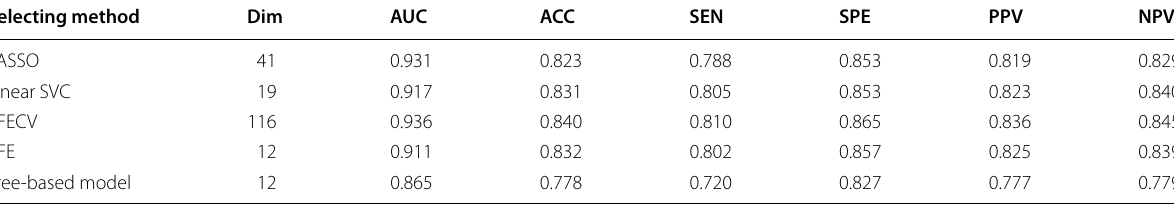
LASSO, Least Absolute Shrinkage and Selection Operator; Linear SVC, Linear Support Vector Classification; RFECV, Recursive Feature Elimination Cross Validation; RFE, Recursive Feature Elimination; Dim, dimension; AUC, area under the receiver operator characteristic curve; ACC, accuracy; SEN, sensitivity; SPE, specificity; PPV, positive predictive value; NPV, negative predictive value